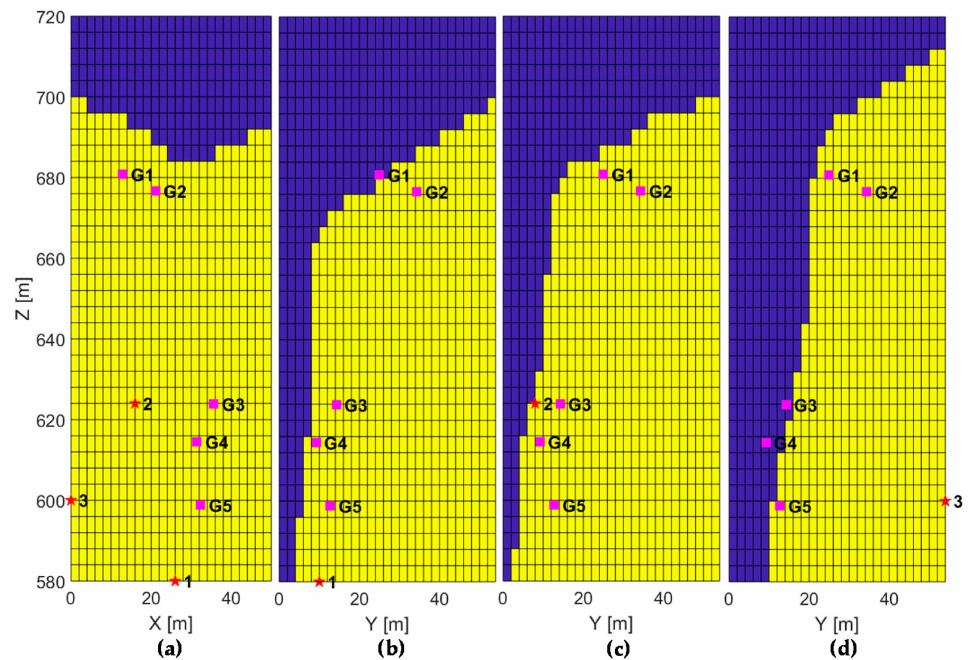
Figure 9. Location results for Rockfall event 7 (Multiple) presented on vertical slices in the front view ( a ) and side views ( b – d ). The blue area is the air, and the yellow area is the rock mass. Pink squares indicate the five 3C geophones projected on the slice. Red stars indicate the event locations projected on the slice and numbers are used to order the signals according to the arrival